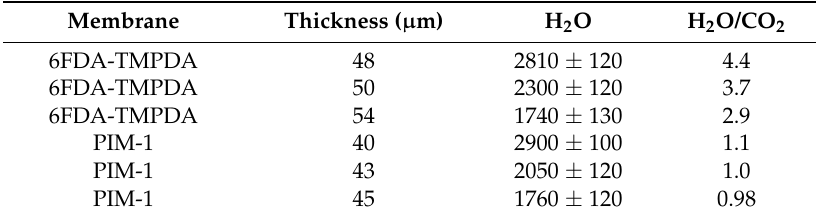
Table 7. H 2 O permeability (barrer) and H 2 O/CO 2 selectivity through 6FDA-TMPDA and PIM-1 composite membranes with Teflon AF1600, denoted by overall membrane thickness, at 35 ◦ C.